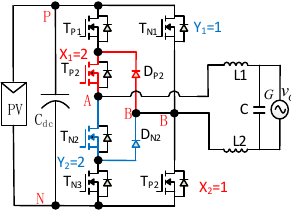
Figure 14. The topology R8 derived from X 1 = 2, X 2 = 1, Y 1 = 1, and Y 2 = 2; [38]. Correspondingly, two topological families under M = 3 and N = 3 are shown in Table 3.